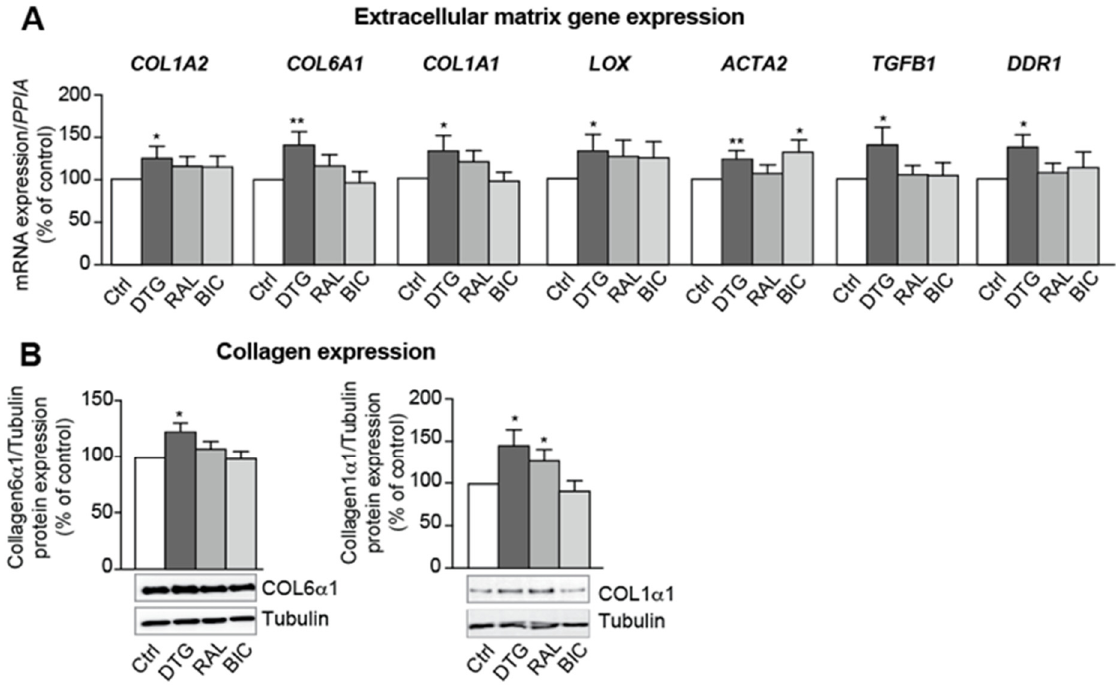
Figure 5. Treatment with INSTIs is associated with elevated extracellular matrix component expres- sion in beige adipocytes. ASCs were differentiated into adipocytes, as described in Figure 2. ( A ) Relative mRNA expression levels of collagens (COL1A2, COL6A1, COL1A1), lysyl oxidase (LOX), actin alpha 2, smooth muscle (ACTA2), TGFB1, and DDR1, were normalized against that of PPIA . The results are expressed as the mean ± SEM % of control cells ( n = 9, in duplicate). ( B ) Whole-cell lysates were prepared and analyzed using immunoblots. Representative immunoblots of COL6 α 1, COL1 α 1, and tubulin are shown. Densitometry analyses against tubulin as loading control were performed and expressed as a mean % of the value for control cells ± SEM ( n = 6). * p < 0.05, ** p < 0.01 vs. control cells.